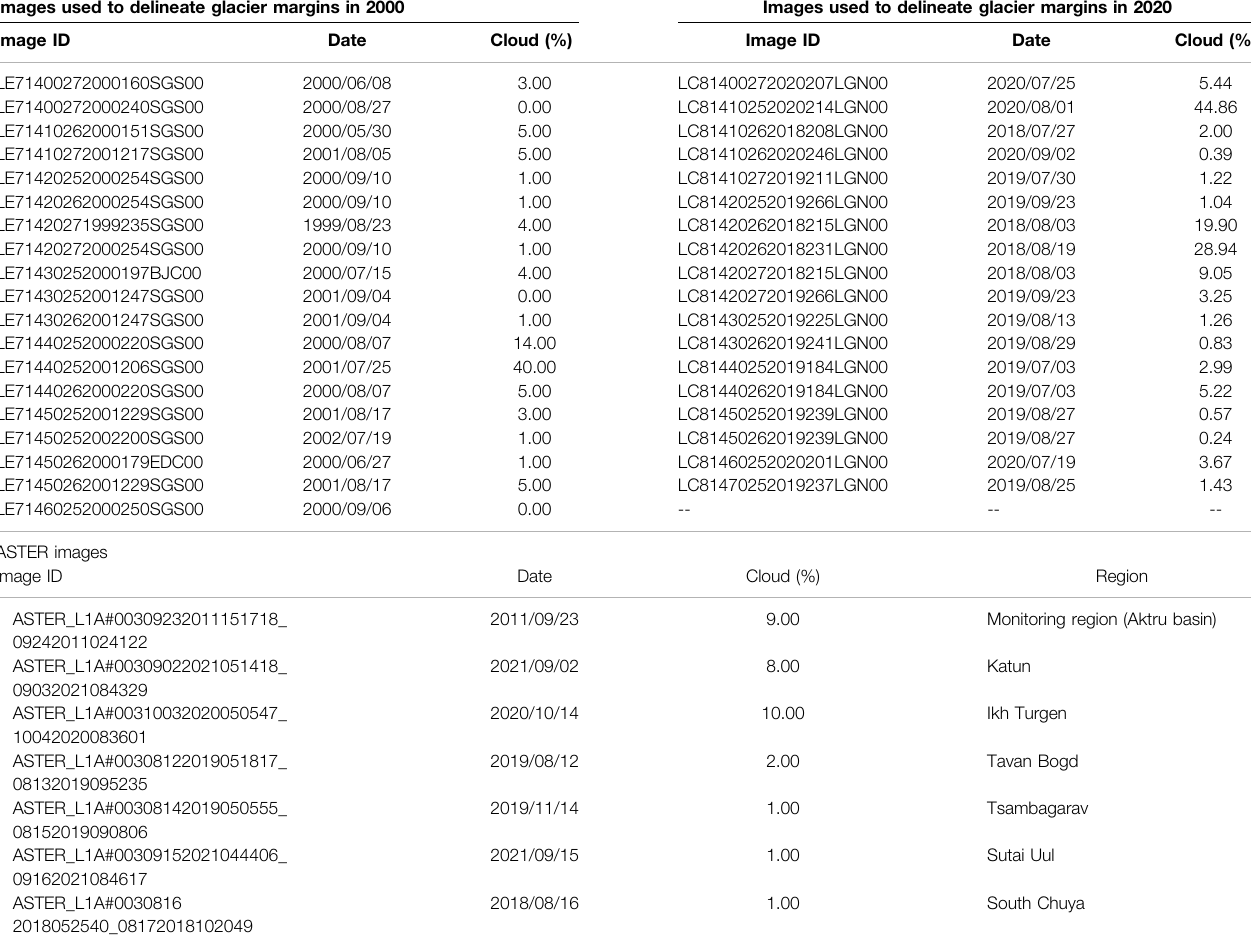
TABLE 1 | Landsat images and ASTER